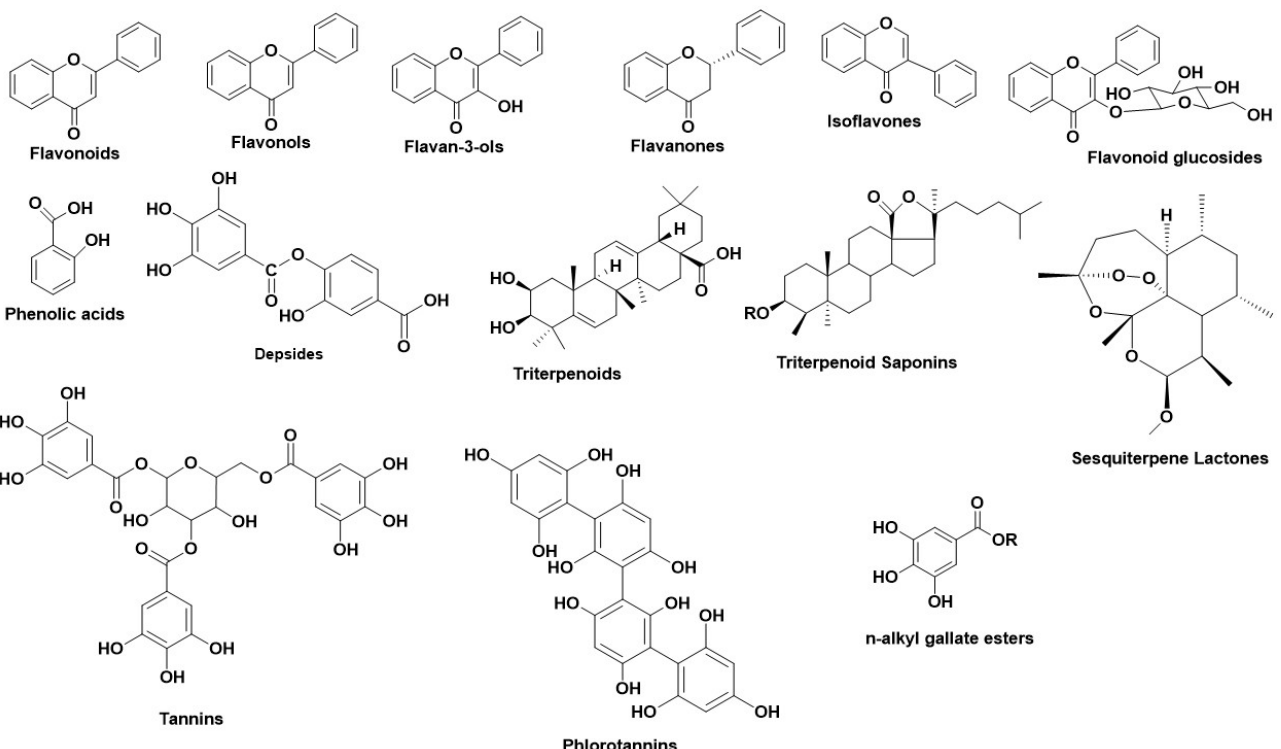
Figure 2. Main structural scaffolds which have been marked as potent Hyal inhibitors.